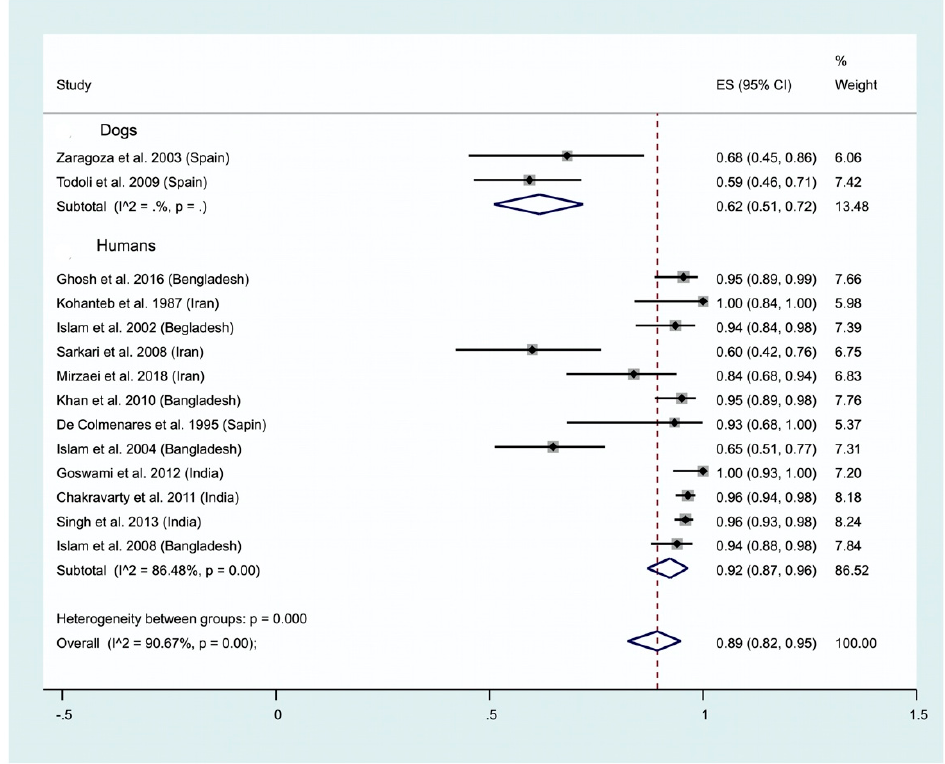
Figure 4. Forest plot representation of the extracted data for urine analysis using antibody detection methods on leishmaniasis with subgroup analysis on dogs and humans.